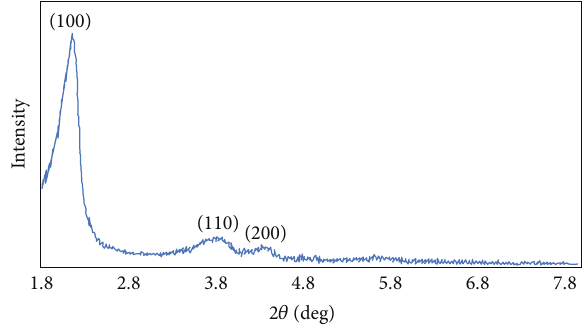
Figure 8: Low angle XRD pattern of silica